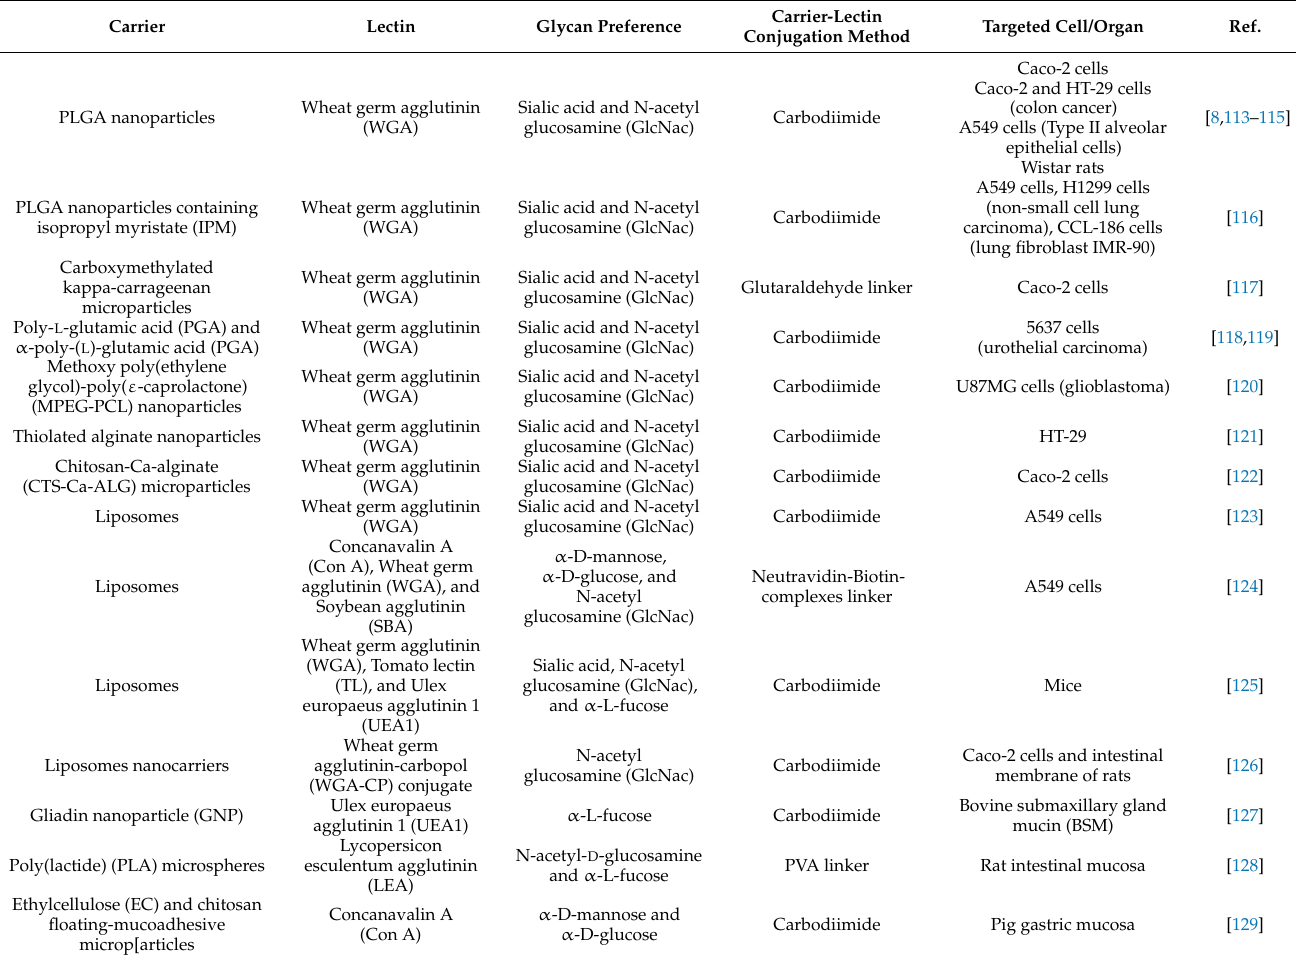
Table 1. An overview of the research on lectin-mediated drug delivery